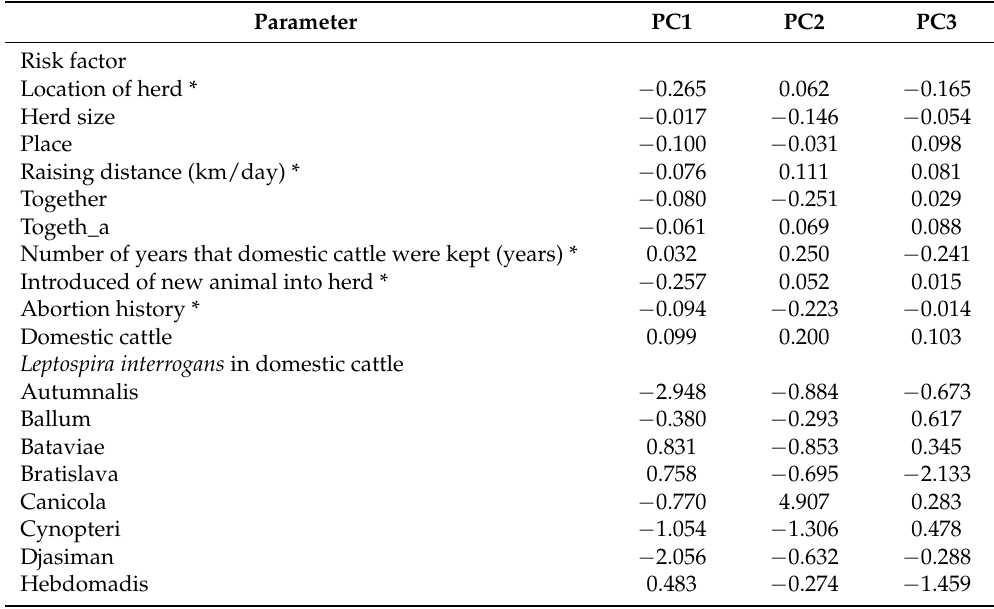
Table 4. Factor loading eigenvalue, environmental factors, seroprevalence, and coordinates of sites of correlative coherence analysis (CCA) around the Salakphra Wildlife Sanctuary.